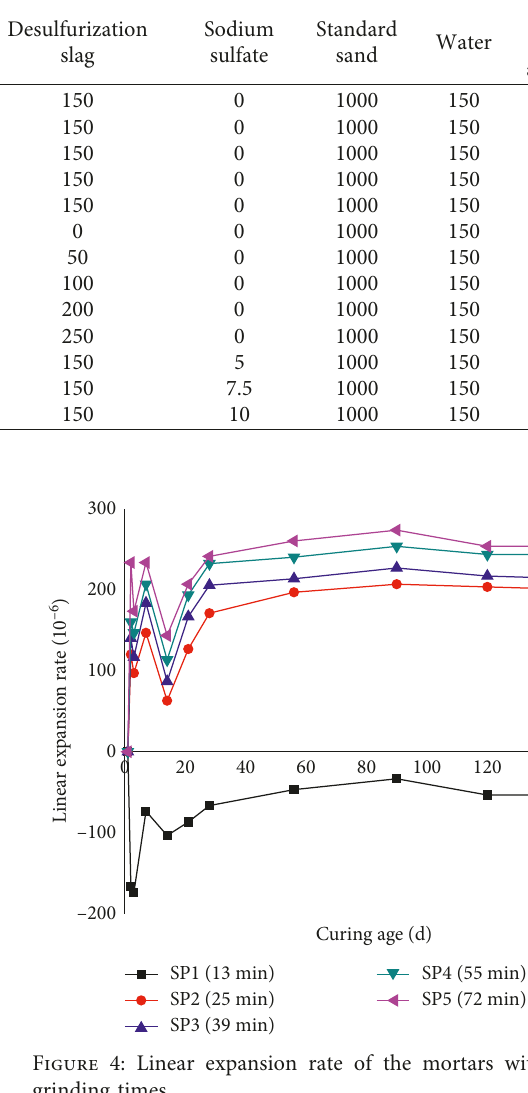
Table 3: Mixture proportions of mortars.